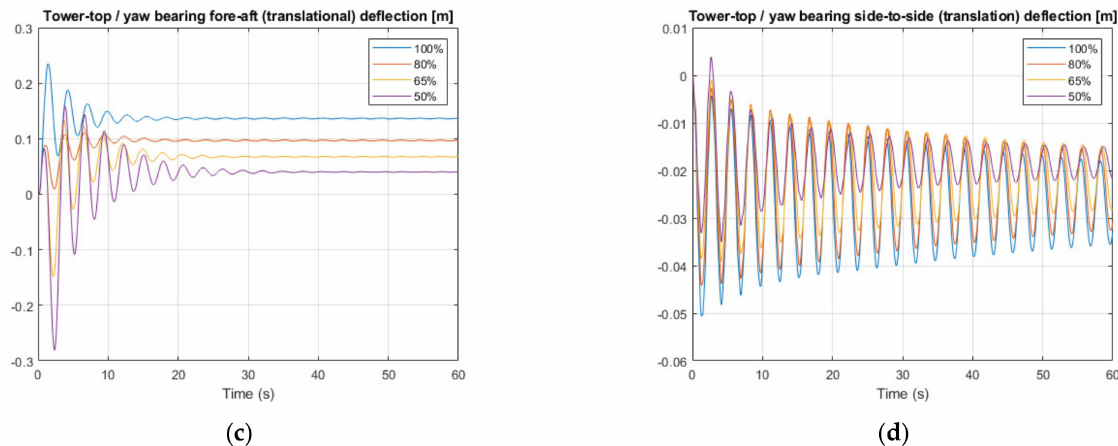
Figure 11. Simulation efforts for different power limitations: ( a ) in-plane blade tip deflection; ( b ) out-of-plane blade tip deflection; ( c ) tower top fore–aft deflection; ( d ) tower top side–side deflection.